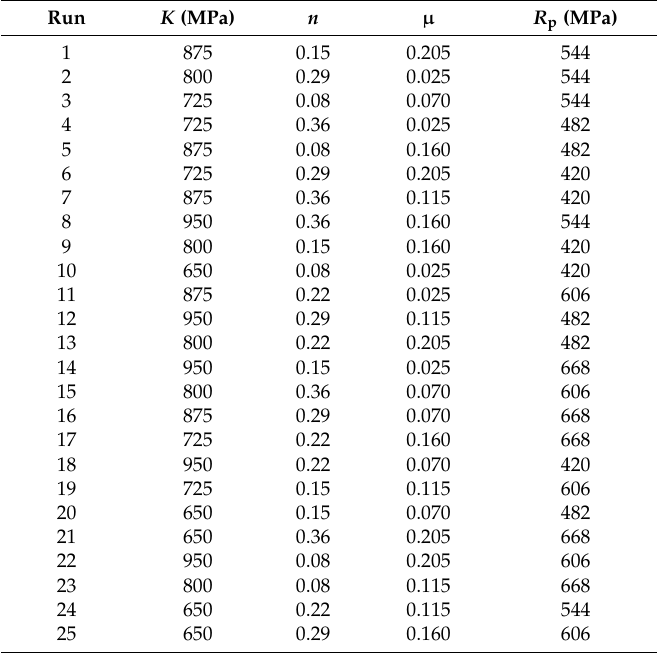
Table 2. Combinations of the analyzed parameters K , n , R p , and µ .